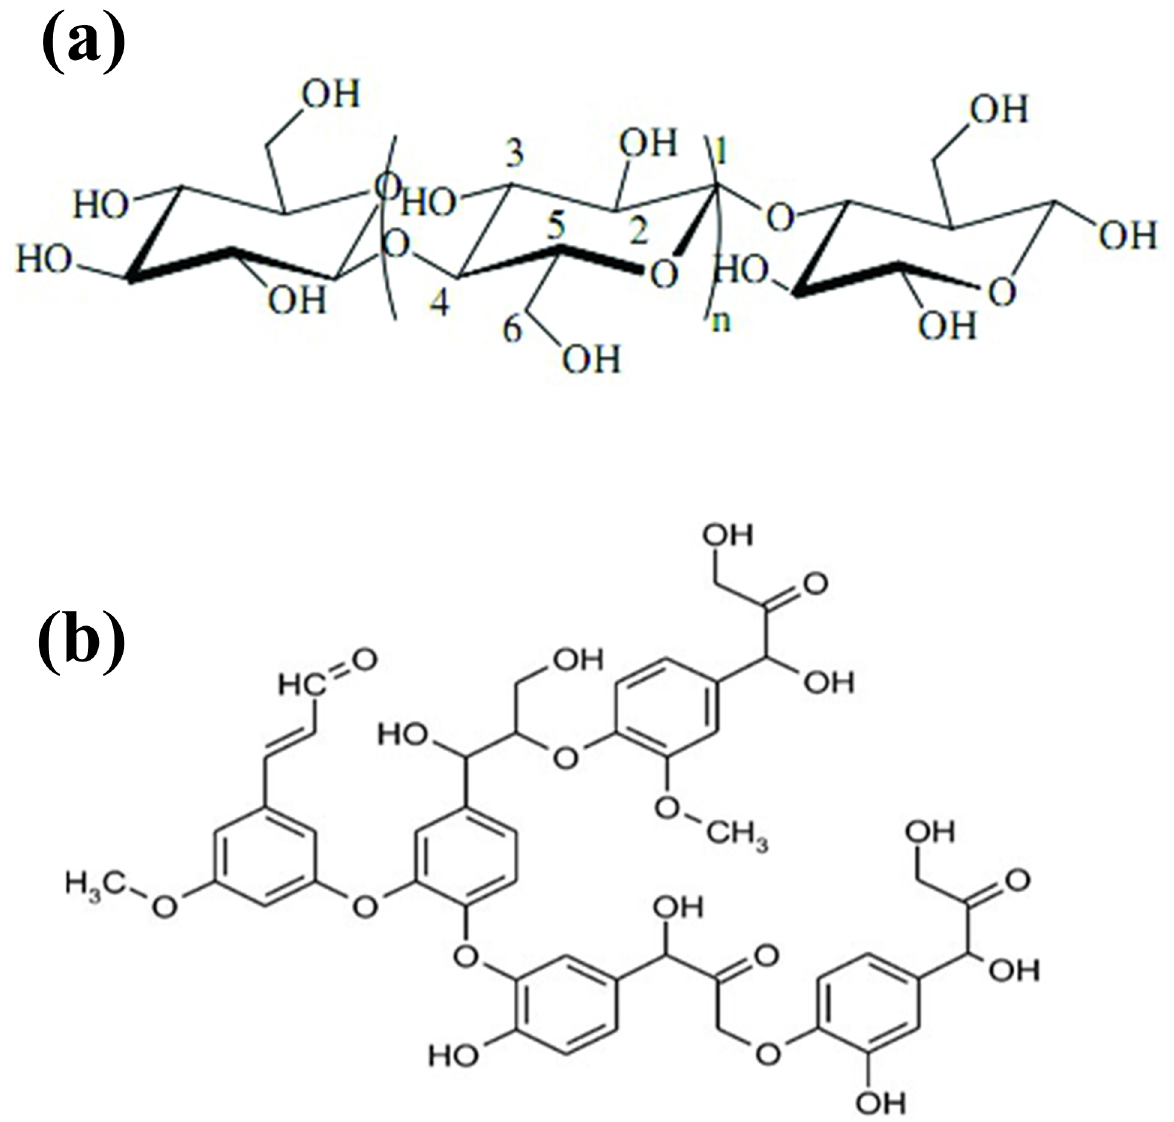
Fig 2. The chemical structures of cellulose and lignin. (a) Cellulose is a carbohydrate polymer consisting of glucose monomer through 1–4 glycoside bonds. (b) Lignin is cross linked phenolic polymer, consisting of three phenol monomers, coumaryl alcohol, coniferyl alcohol, and syringyl